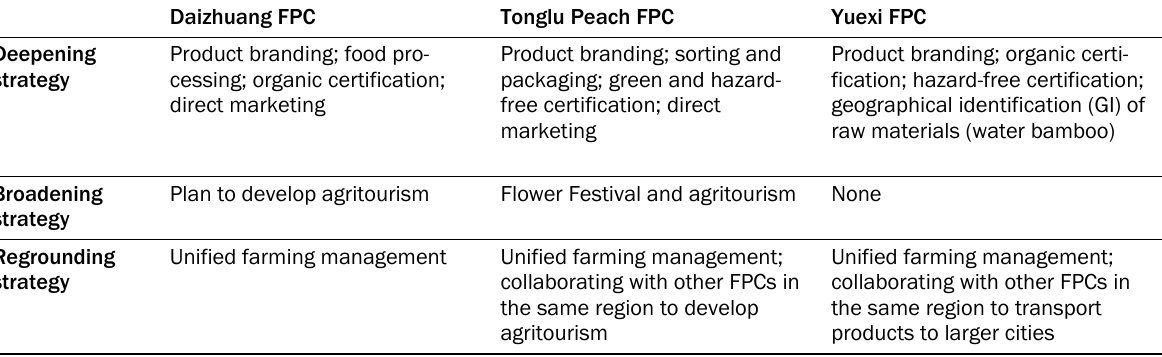
Table 3. Typology of Strategies Pursued by the Three